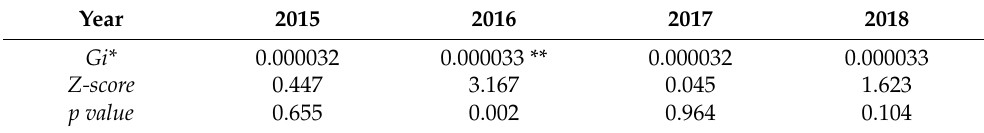
Table 3. Spatial–temporal heterogeneity effects of poverty levels from 2015 to 2018.